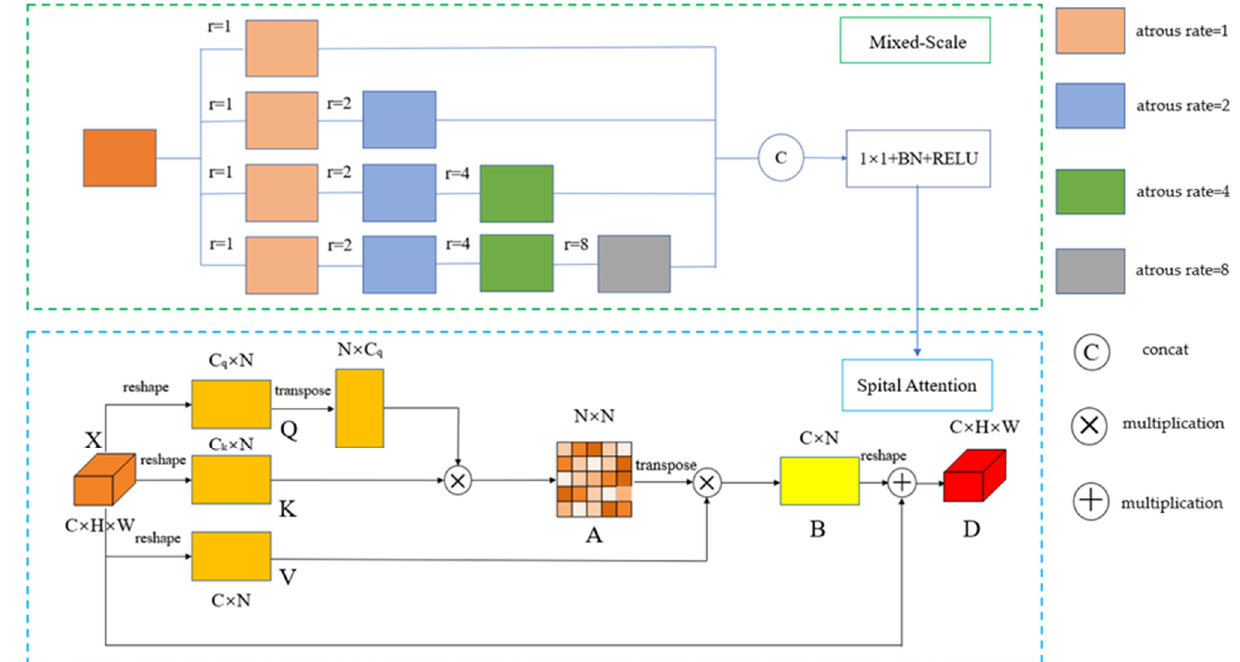
Figure 3. Mixed-scale spatial attention